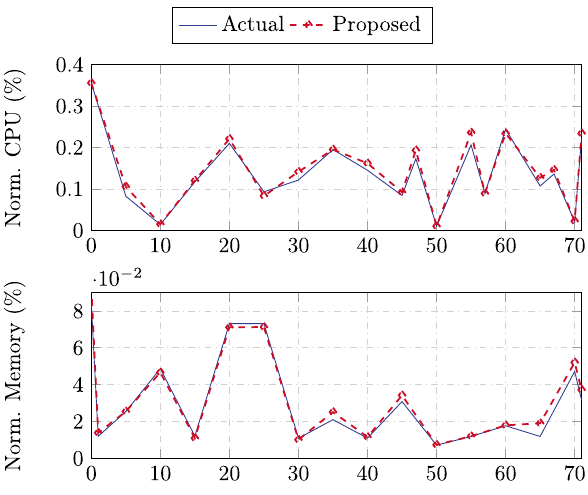
Figure 1. CPU and memory prediction accuracy.